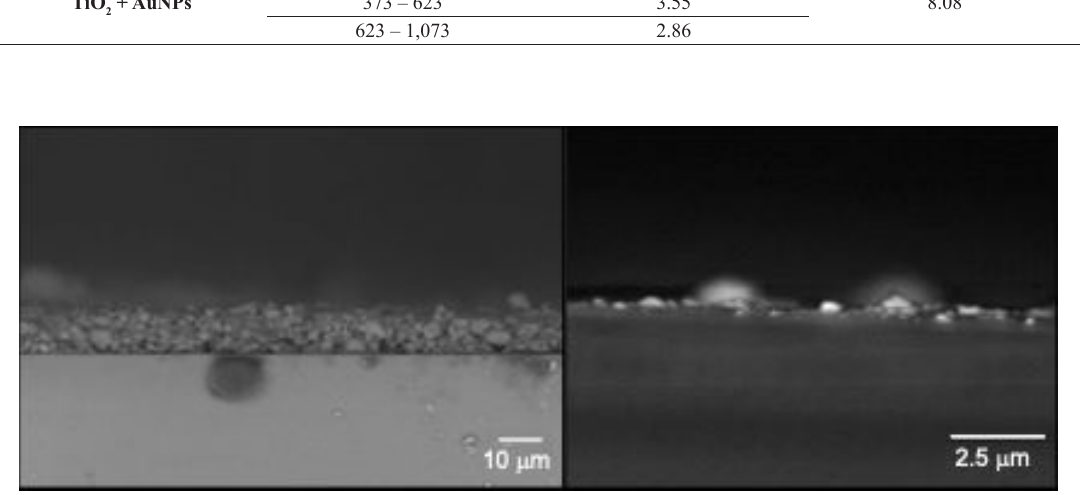
Figure 5. SEM visualizations: secondary electrons image of TiO image of Au/TiO filme with 10,000 X magnification (right). 2